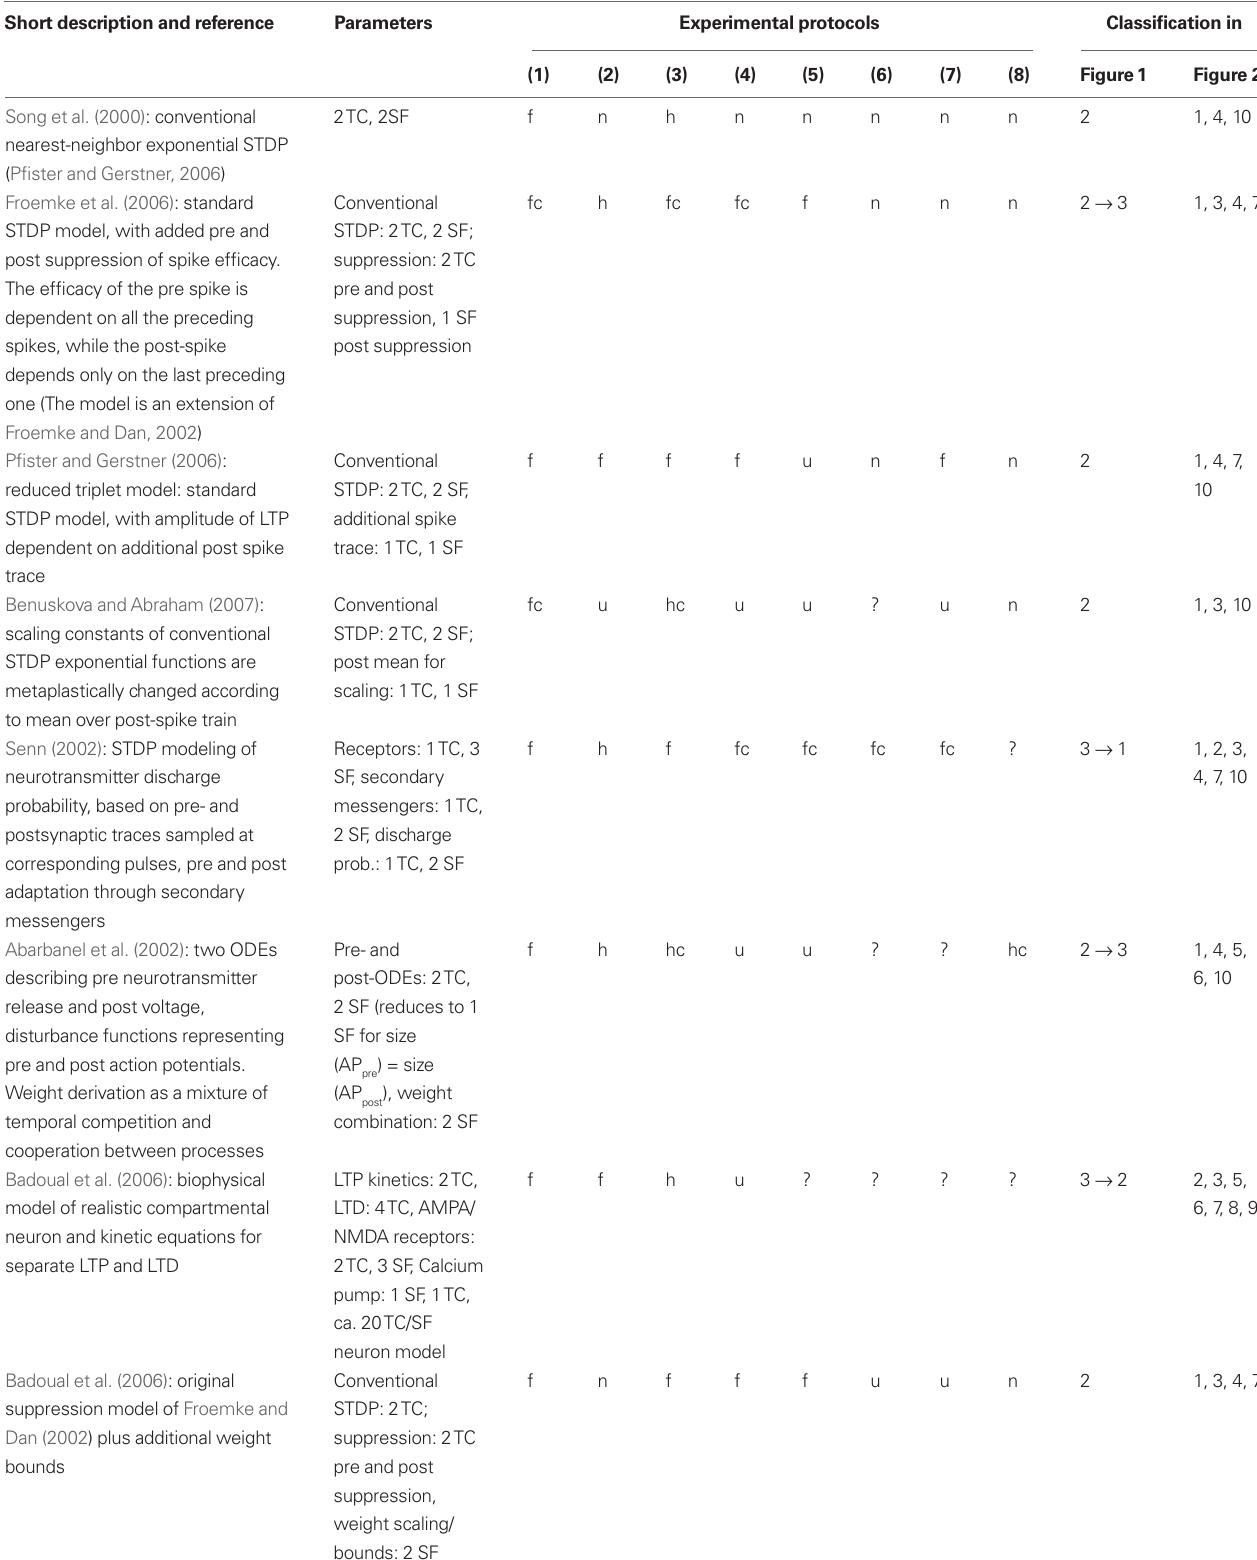
Table 3 | Comparison of models for LTP and